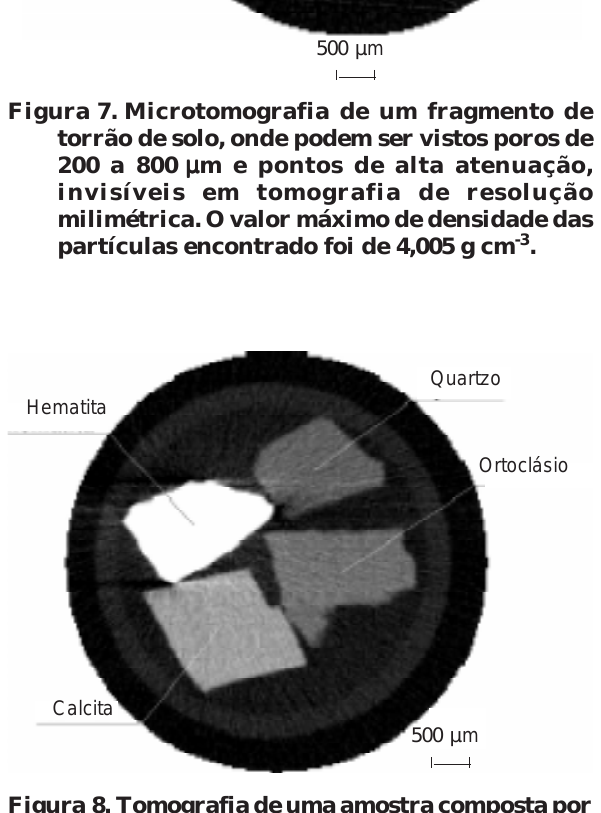
Figura 8. Tomografia de uma amostra composta por cristais de quartzo, ortoclásio, hematita e calcita, apresentando densidades reais, respectivamente, de 2,525, 2,586, 5,081 e 2,793 g cm -3 . Os valores foram obtidos pelo método aqui